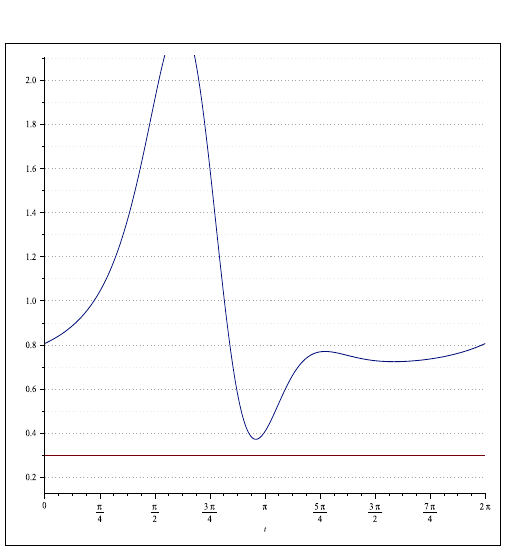
(cid:16) (cid:17) e it for t ∈ [ 0,2 π ] , and v =